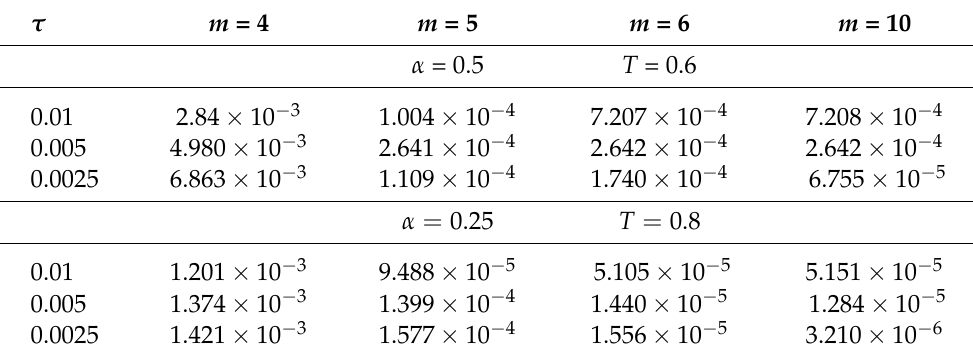
Table 1. The AAA algorithm: errors e C ( N , J ) of the solution of the discrete scheme (12) for α = 0.5,0.25 and a sequence of parameters m